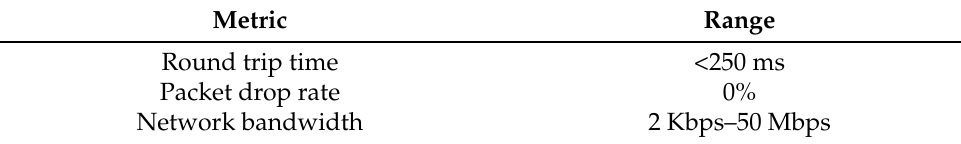
Table 1. Network performance requirements for telemetry applications.